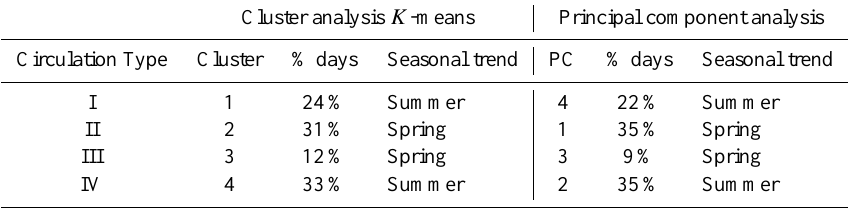
Table 2. Comparison of the four circulation types obtained from Cluster Analysis and Principal Component Analysis. Cluster analysis K -means